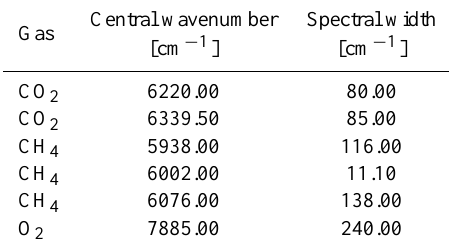
Table 1. Standard TCCON retrieval windows for CO 2 , CH 4 and O 2